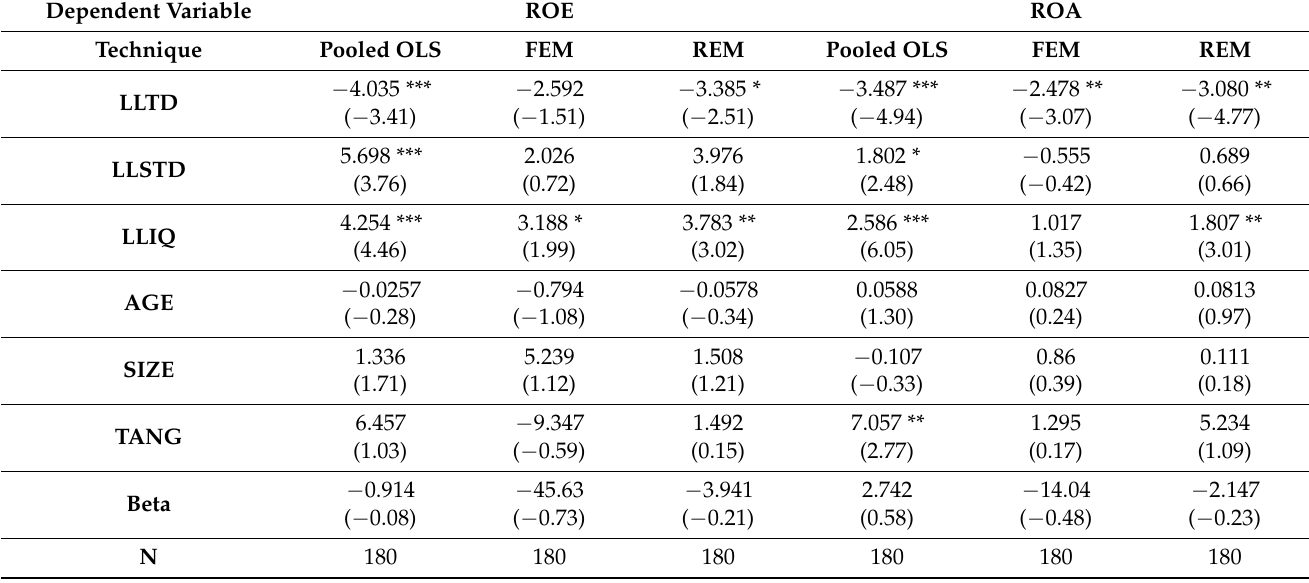
Table 4. Regression